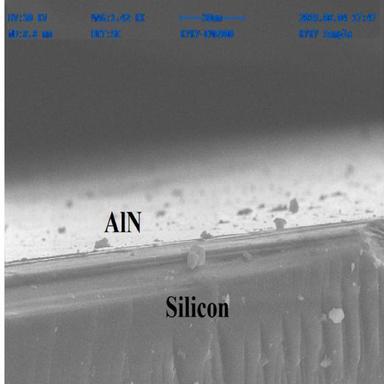
SEM image of the AlN layers on Silicon substrate.